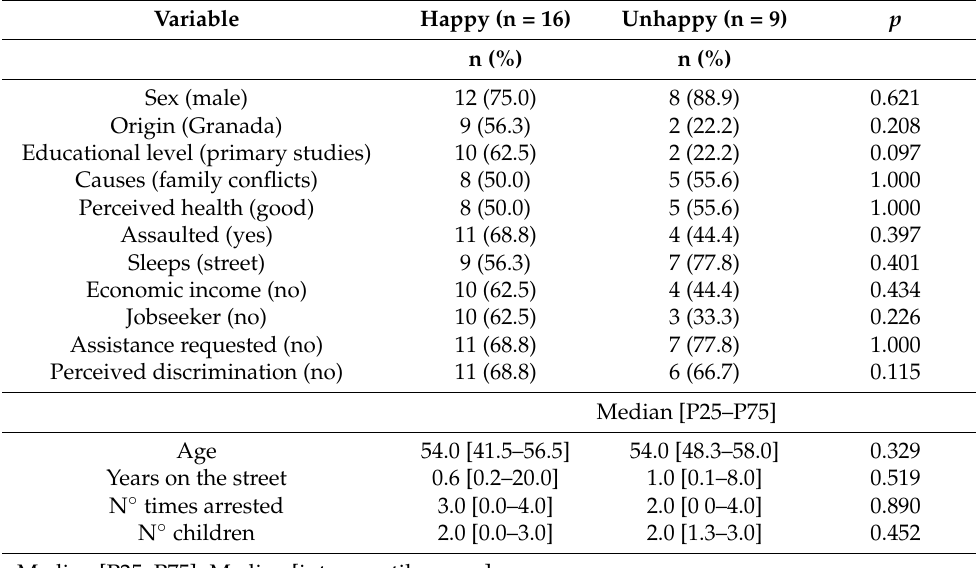
Table 2. Association of the question “Do you feel happy?” (yes/no) with other study variables.